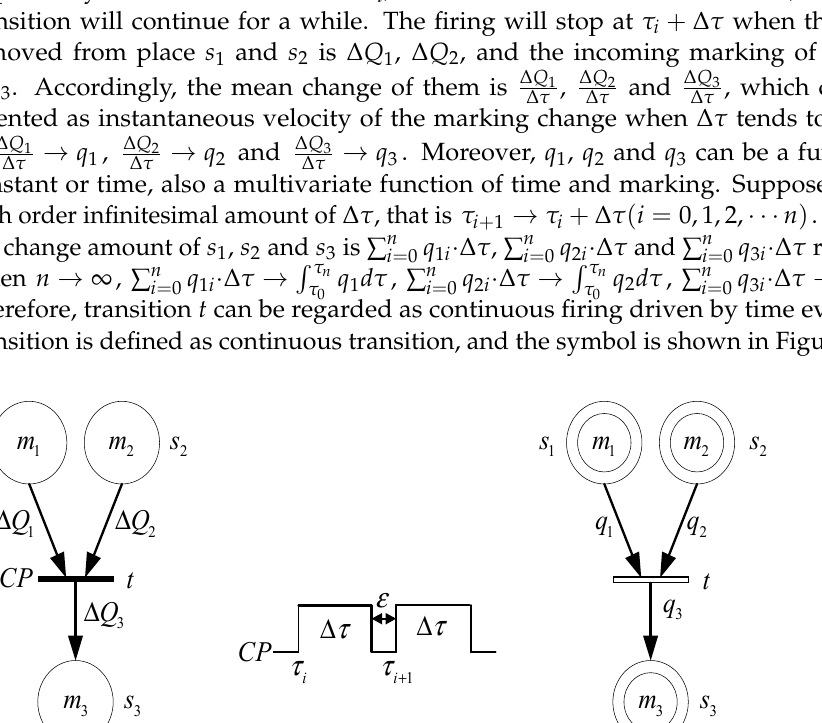
Figure 3. Inhibit arc and permit arc.